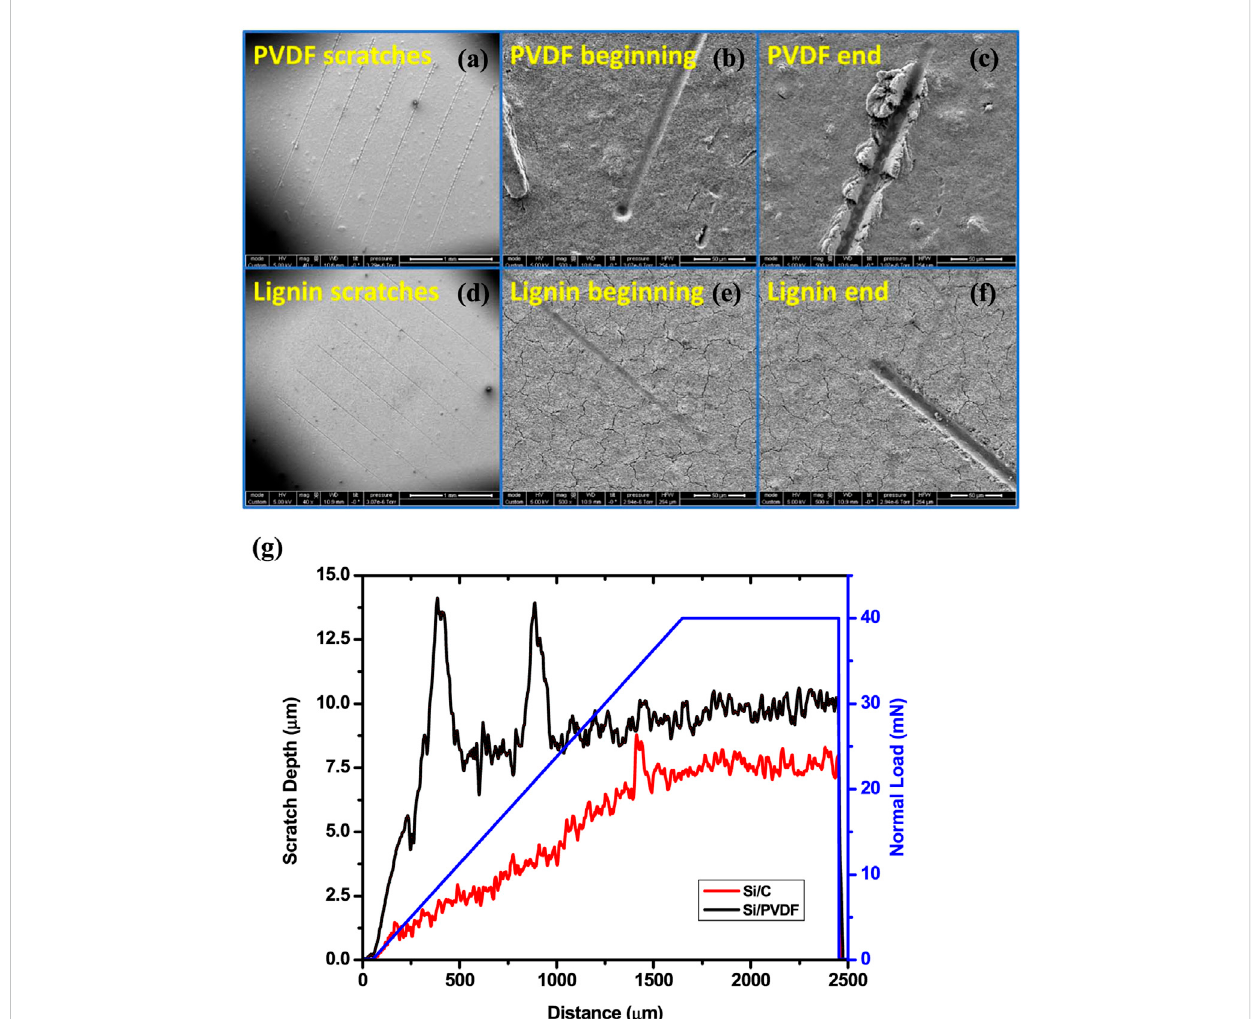
FIGURE 6 ScratchtestresultsofthePVDFandKLelectrodes:SEMimagesofthe (A) overall, (B) beginningand (C) endofmicro-scratch tracksfortheelectrode withPVDFbinderand (D) overall, (E) beginningand (F) endofmicro-scratchtracksfortheelectrodewithKLbinder; (G) Scratchdepthpro fi lesofthePVDF and KL binders as a function of scratch distance (Li et al.,